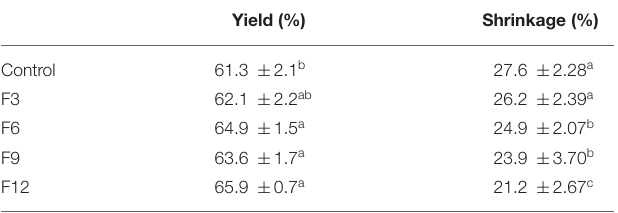
TABLE 3 | Yield and shrinkage of prebiotic burgers.